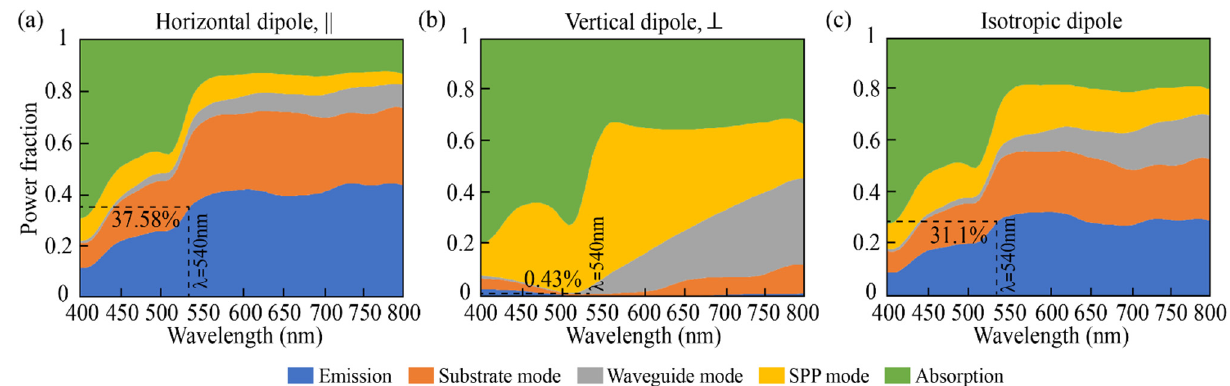
Figure 3. Reallocation of the perovskite emitted power in one of the five channels here considered: emission, substrate mode, waveguide mode, SPP mode, and absorption when horizontal ( a ), vertical ( b ), and isotropic dipole ( c ) are considered. The layers thicknesses are: 100 nm, 50 nm, 30 nm, 40 nm, and 200 nm for Ag, Spiro-OMeTAD, CsPbBr3 (with ρ = 0.6), ZnO, and ITO, respectively.